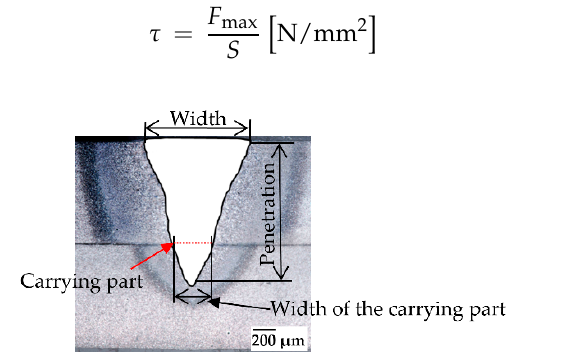
Figure 5. Schematic presentation of the weld carrying cross-section surface